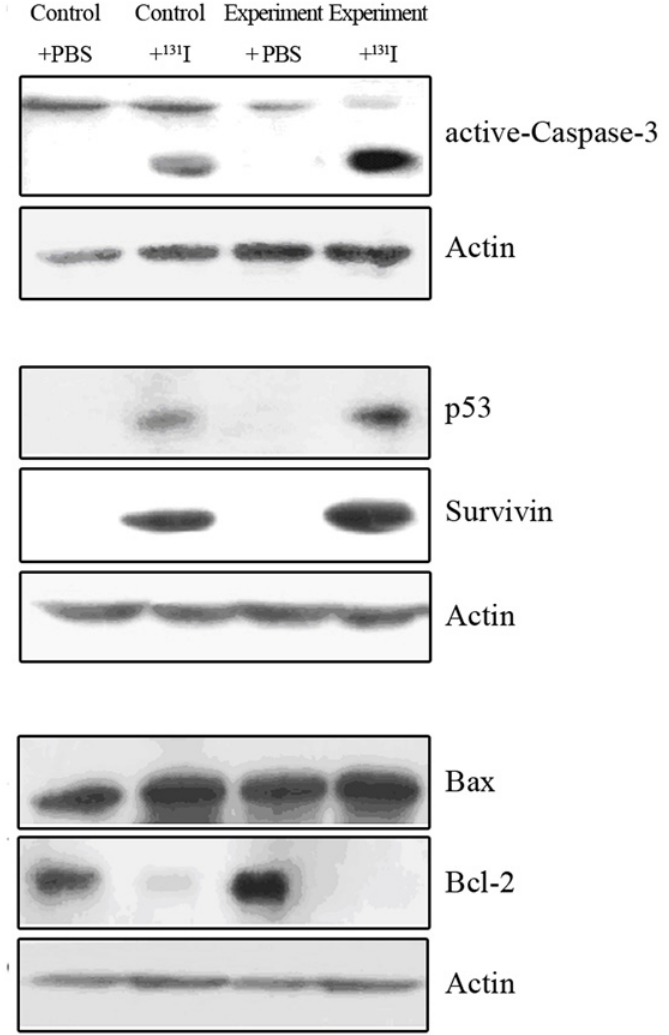
but Bcl-2 protein was decreased in CNE-2-hNIS cells compared to CNE-2